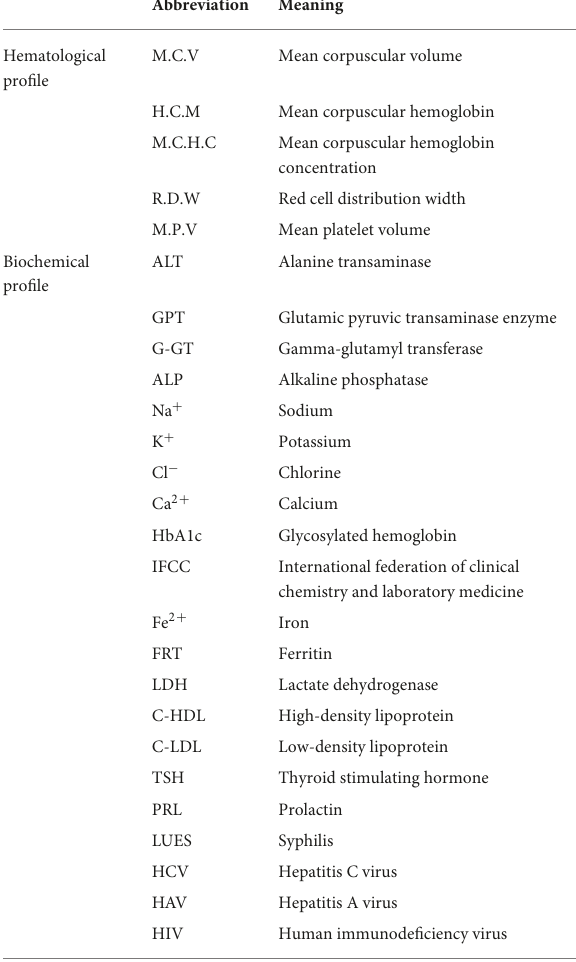
TABLE 1 Blood test variables: